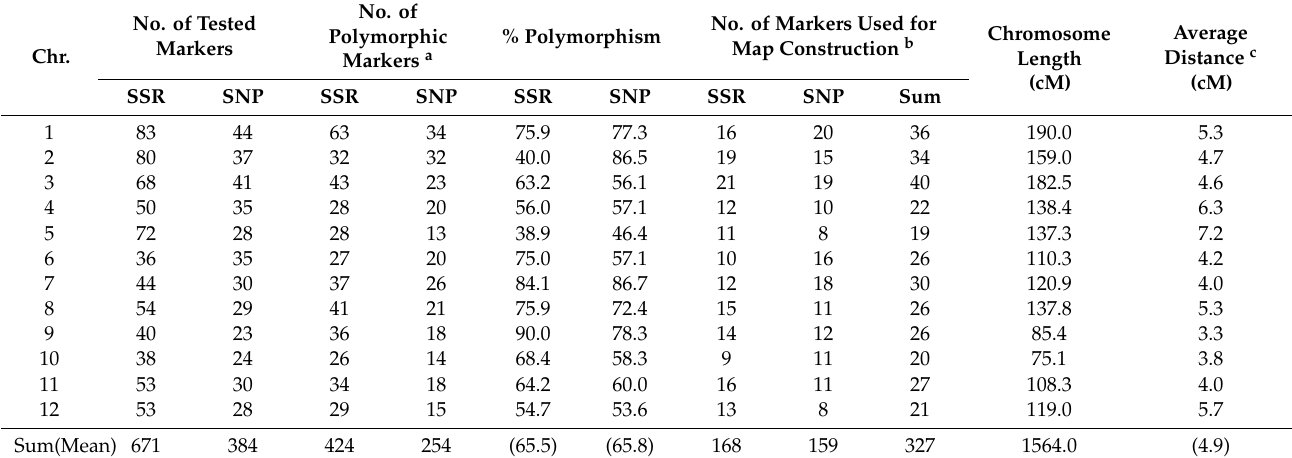
Table 4. Summary of molecular markers used for genotyping and linkage map construction.